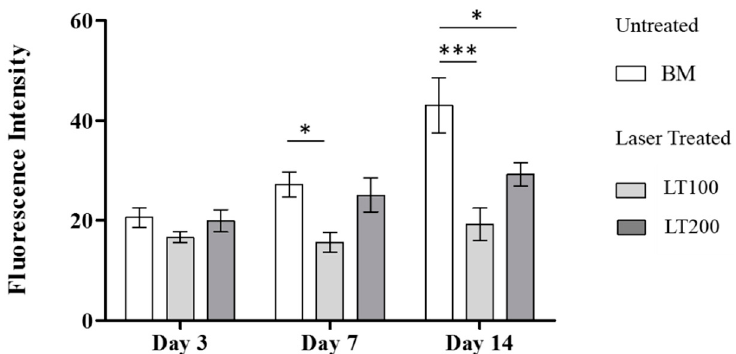
Figure 6. Fluorescence intensity of MSCs at Day 3, 7 and 14 proliferation time points on untreated and laser treated surfaces. The error bars indicate the SE of n = 3.